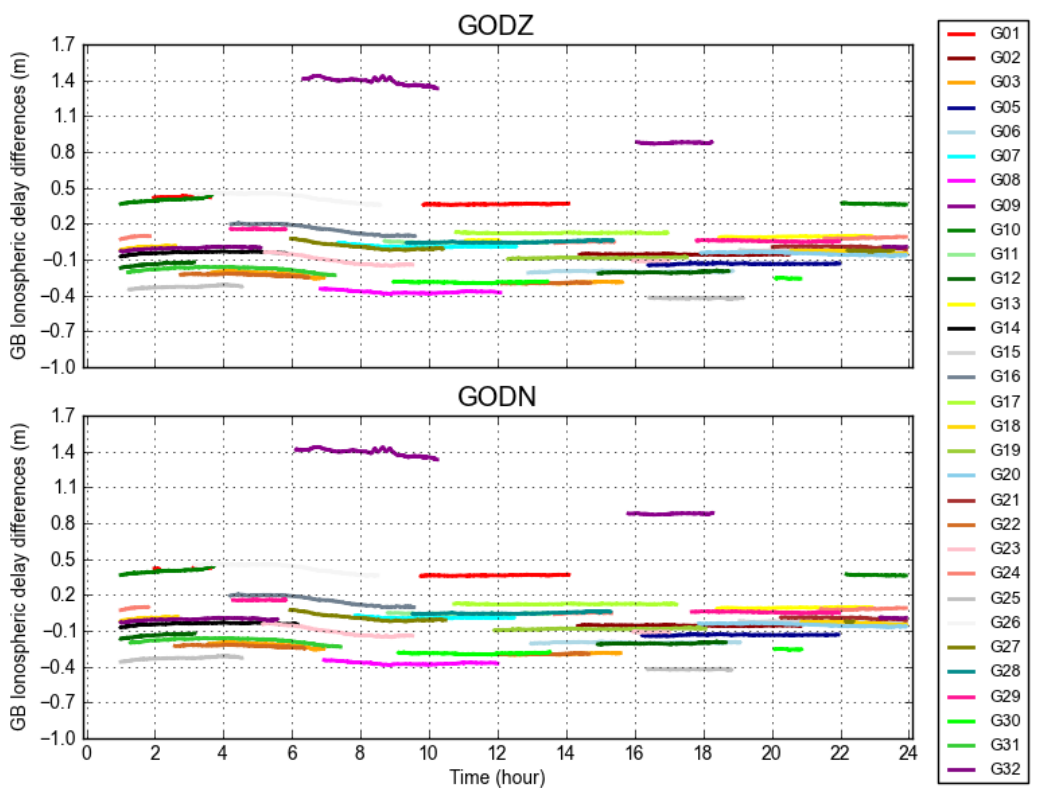
Figure 8. Differences of GB ionospheric delays for all of the observed satellites computed from the receiver GODZ (top) and GODN (bottom) observations with final and real-time OC products.